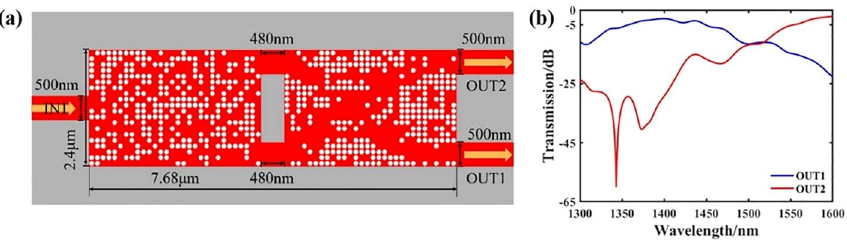
Figure 5. Design and simulation results of the initial structure after combination. ( a ) Schematic diagram of the structure. ( b ) is the transmittance spectrum of each output